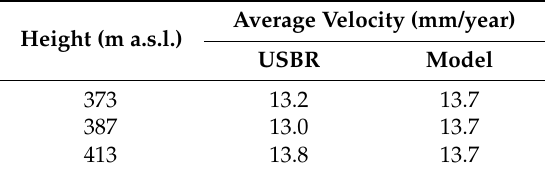
Table 10. Extensometer USBR 7 at different heights vs. model. Height (m a.s.l.)